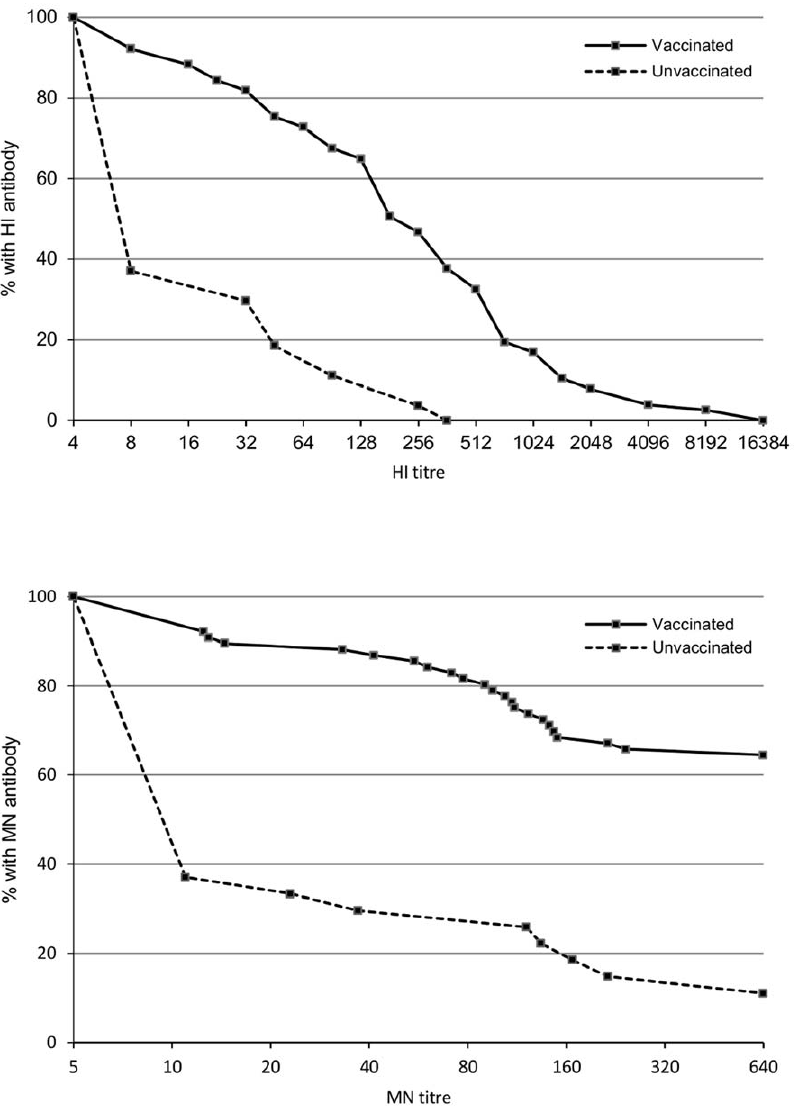
Figure 1. Reverse cumulative distribution curves of haemagglutinination inhibition and microneutralization antibody titres in cord blood serum samples. (Titres are expressed as reciprocal of the dilution and are given on a log 2 scale.) [33].